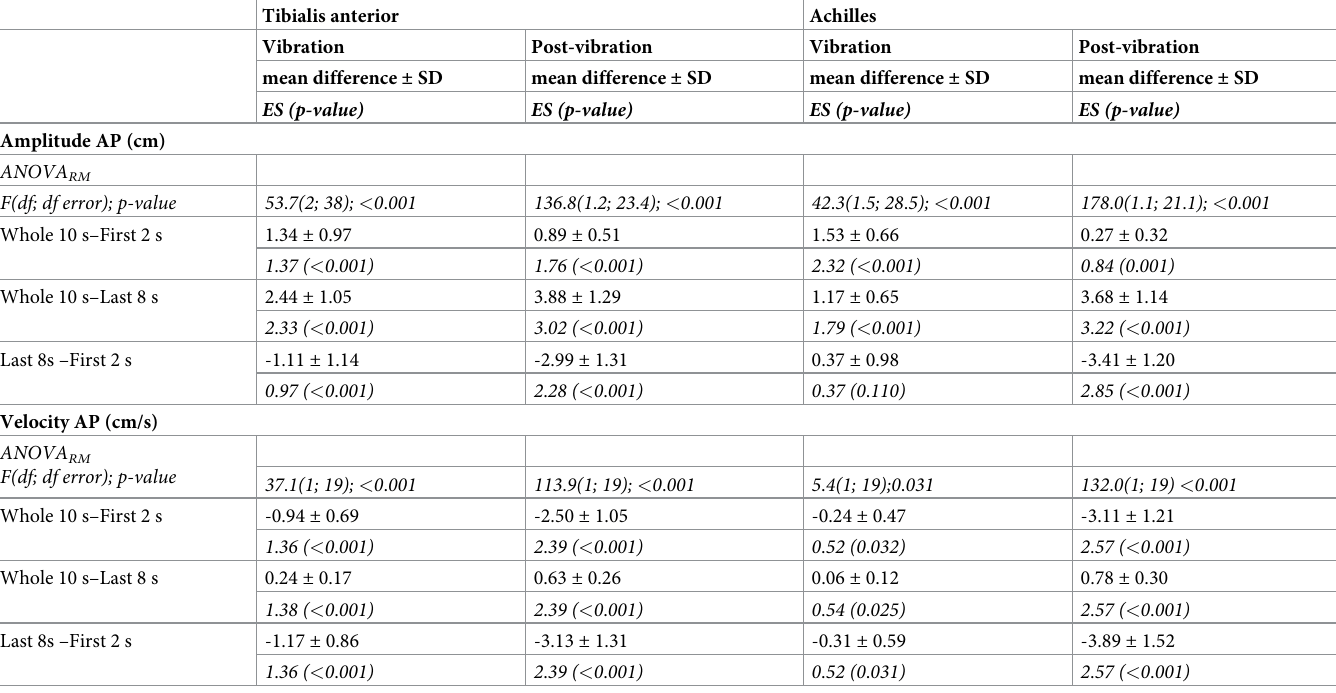
Table 2. Results of statistical comparisons between time-windows for the tested conditions of vibration. Tibialis anterior Achilles Vibration Post-vibration Vibration Post-vibration mean difference ± SD mean difference ± SD mean difference ±